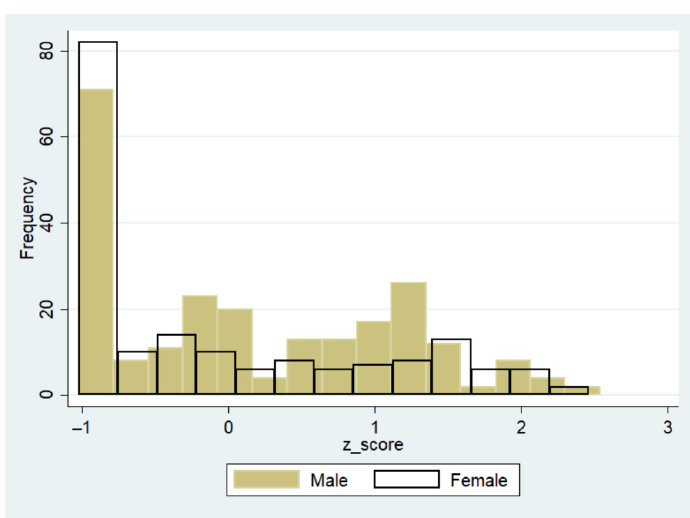
Figure 2. Financial literacy scores by gender.